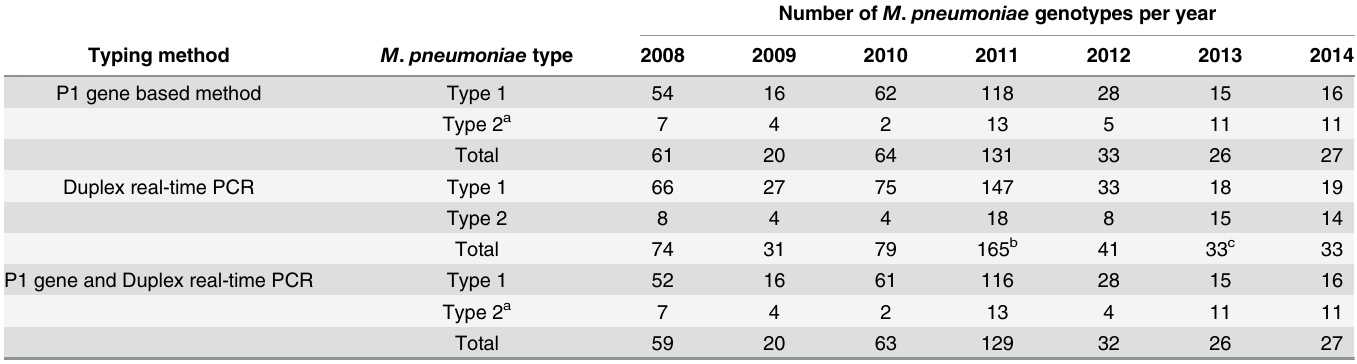
Table 6. M . pneumoniae genotypes in clinical specimens collected from 2008 to 2014 in Beijing,